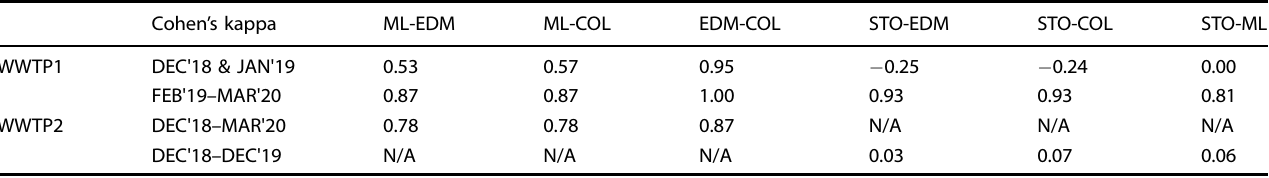
Table 2. Agreement of ML classi fi cation, EDM, COL and STO alarms for the supervised learning.